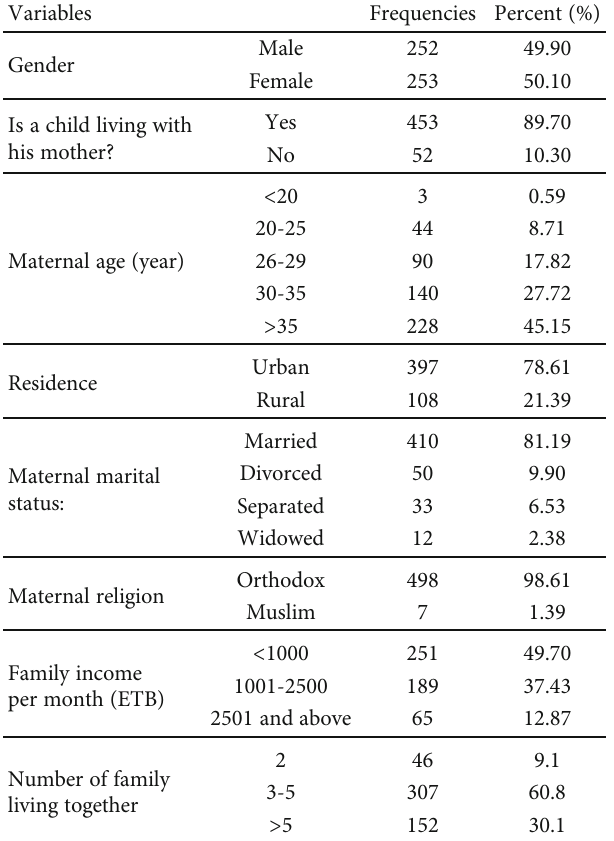
Table 2: Descriptive results of academic performance of primary school children in Lalibela ( N = 505 ),